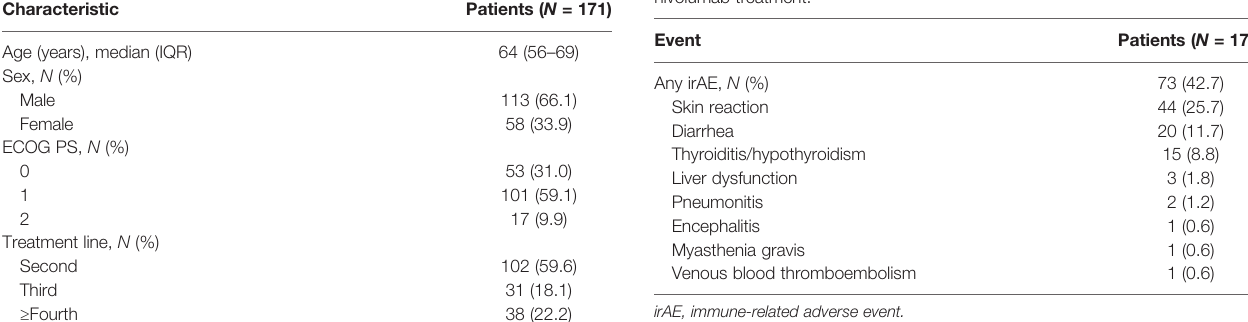
irAE, immune-related adverse event.